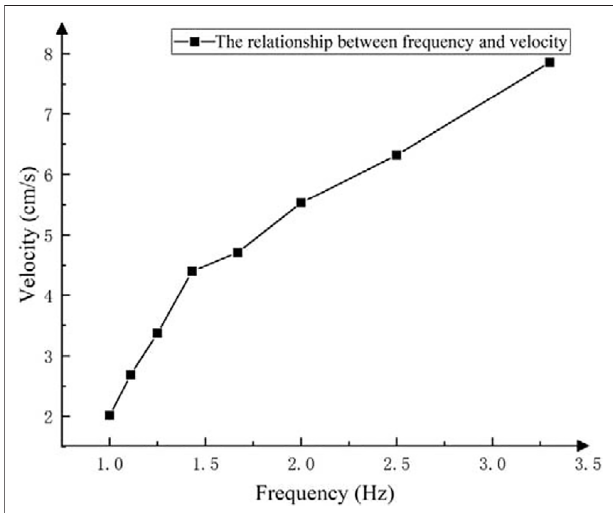
FIGURE 14 | The relationship between motion velocity and the frequency.